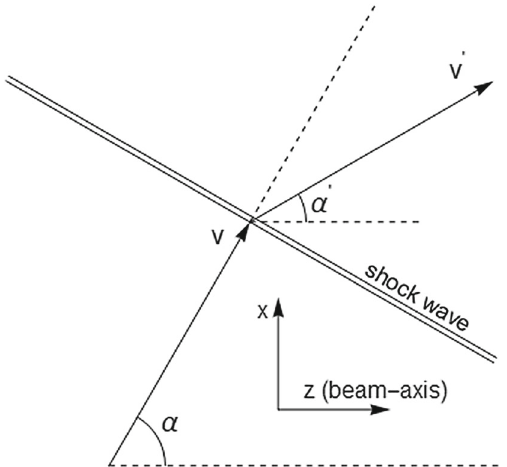
Fig. 3 Transformation of flow velocity by the shock wave front. Upstream flow moves with velocity v at an angle α to the direction of anisotropy (beam axis) and downstream flow moves with velocity v (cid:2) at an angle α (cid:2) to the beam